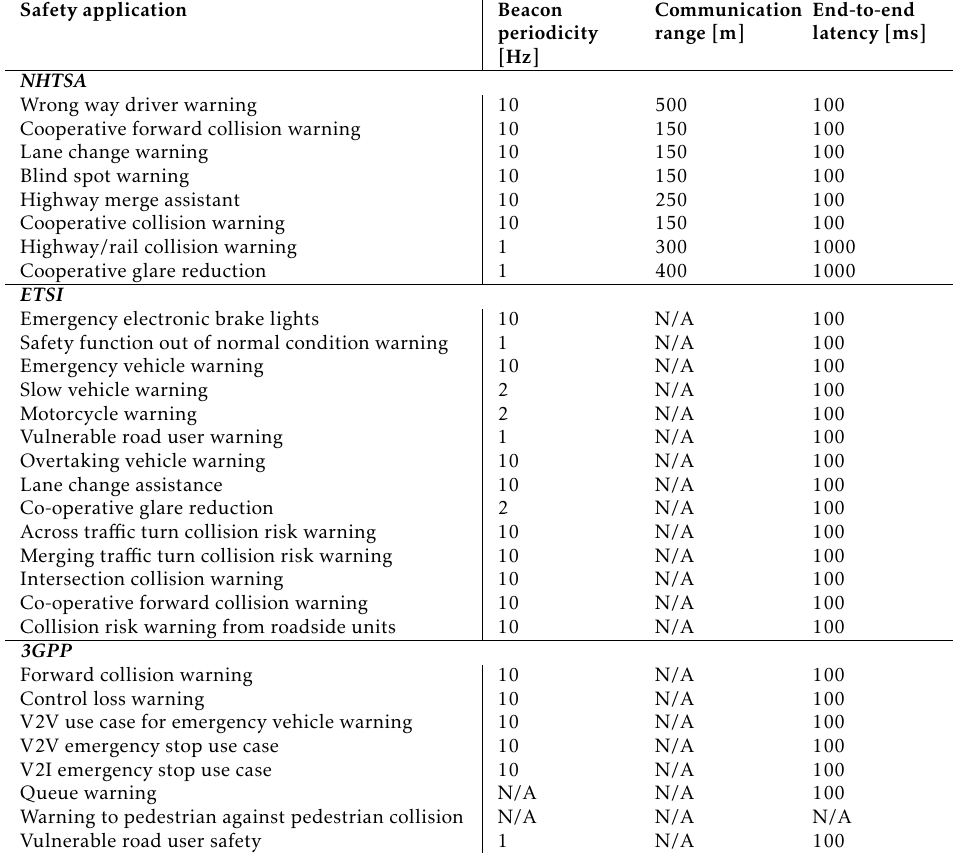
Table 1. Safety applications and requirements for NHTSA, ETSI, and